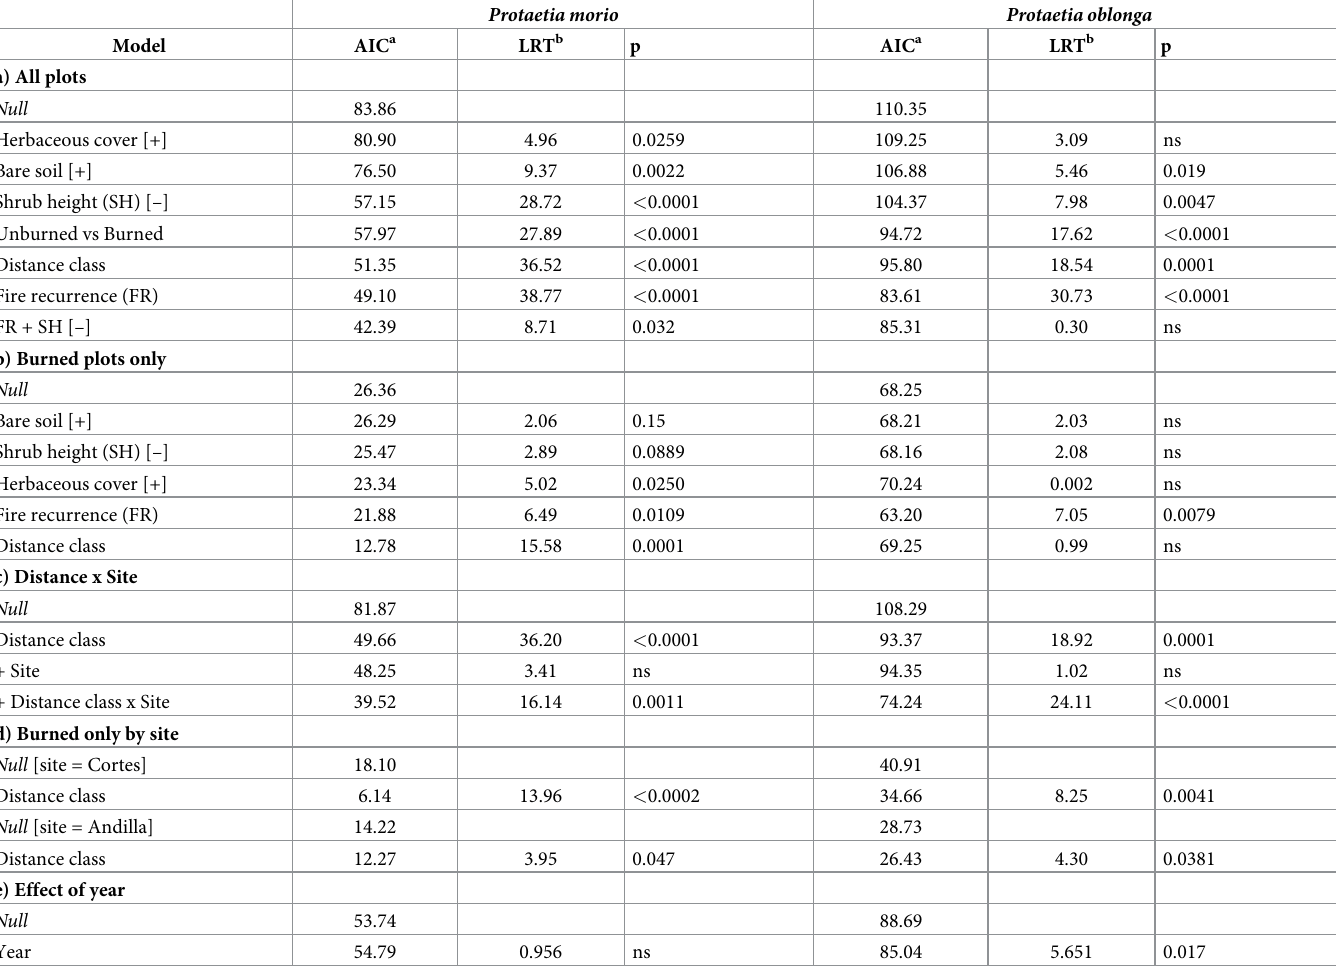
Table 2. Summary of the linear mixed models relating abundance of the two Protaetia species with fire and site variables. Protaetia